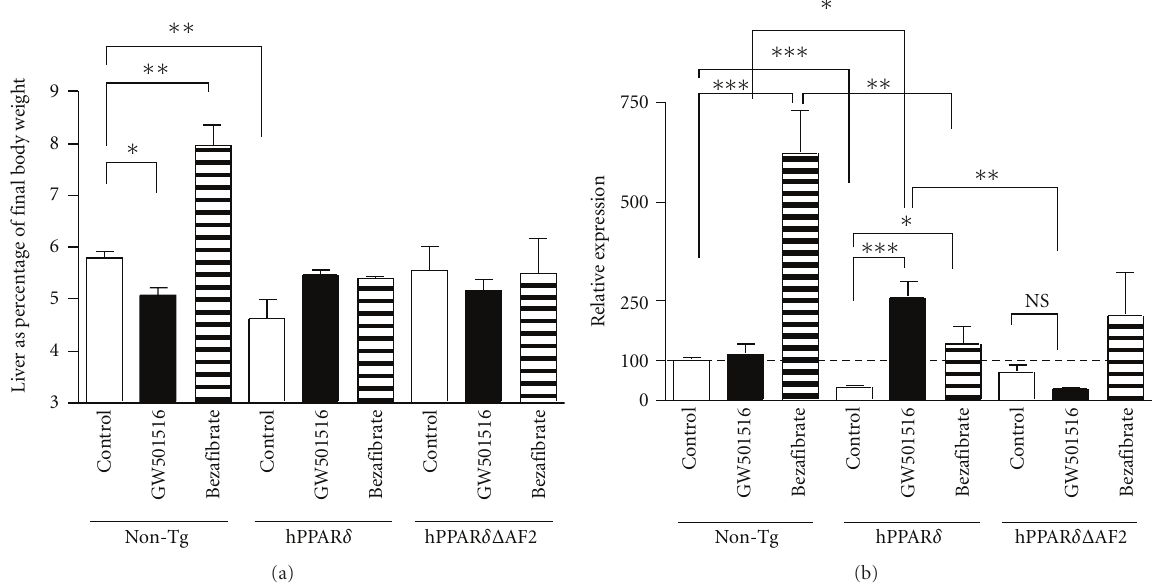
Figure 4: Expression of hPPAR δ and hPPAR δ Δ AF2 abolish bezafibrate-induced hepatomegaly in liver. Animals ( n = 2–4 animals per group) were fed a diet containing I3C (0.5% (w/w)) for 10 days prior to being placed on diets containing I3C (0.5% (w/w)) (Control diet; open bars), or a diet containing I3C (0.5% (w/w)) and GW501516 (0.005% (w/w)) (GW501516 diet; black bars) or a diet containing I3C (0.5% (w/w)) and bezafibrate (0.5% (w/w)) (bezafibrate diet; striped bars) for a further 10 days. (a) Liver weights of animals are expressed as a percentage of body weight. (b) Liver Acox1 mRNA expression. Graphs were analysed using the Mann-Whitney non-parametric test in GraphPad Prism version 5.0c, GraphPad Software, San Diego, California, USA. Significance is indicated as ( ∗ P ≤ 0 . 05; ∗∗ P ≤ 0 . 01; ∗∗∗ P ≤ 0 . 001). GW501516 (Figure 4(b)). In contrast, hPPAR δ